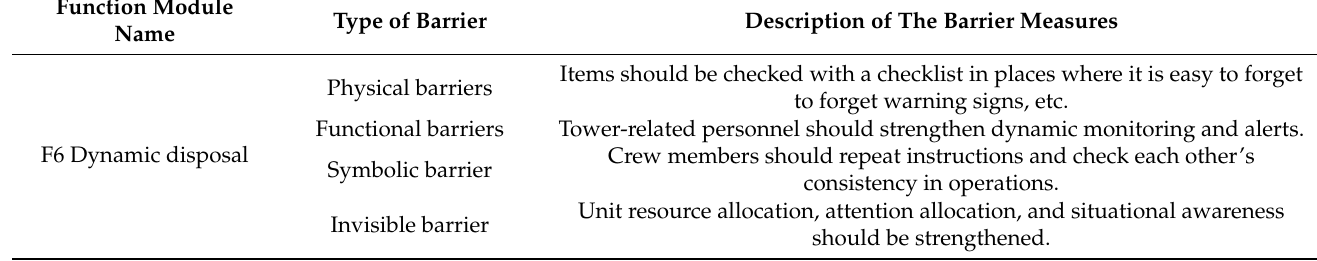
Table 15. “F6: Dynamic Disposal” security